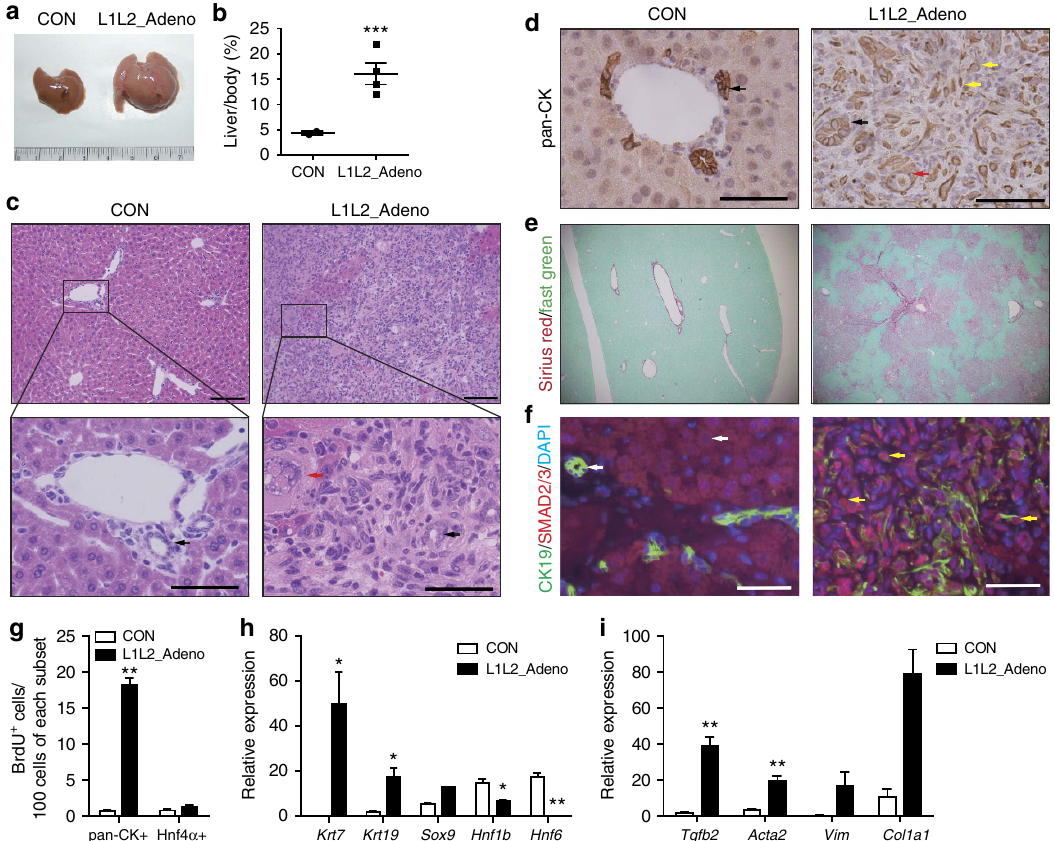
Figure 5 | Loss of Lats1/2 in adult livers causes rapid expansion of immature BECs and activation of TGF b signalling. ( a , b ) Photograph ( a ) shows livers of adeno-Cre (2X10 8 PFU)-injected control and Lats1 (cid:2) / (cid:2) ; Lats2 fl/fl mice (L1L2_Adeno) and dot graph ( b ) of liver to body weight ratio of adeno-Cre virus injected livers. ( c – f ) Representative images of haematoxylin and eosin (H&E) ( c ), anti-pan-CK ( d ), Sirius red and Fast green ( e ) and, anti-SMAD2/3 and anti-CK19 ( f ) staining of control and L1L2_Adeno livers. Black arrows indicate tubular bile ducts and yellow arrows indicate immature BECs. Red arrows indicate LCCs in hepatocytes. Scale bars in ( c ) up indicate 100 m m and scale bars in ( c ) bottom indicate 50 m m. Yellow arrows in d indicate pan-CK-positive signal. White arrows in f indicate cytoplasmic SMAD2/3 signal in CK19-positive cells; Yellow arrows in f indicate nuclear SMAD2/3 signals in CK19- positive cells. Scale bars in d and f indicate 50 m m. ( g ) Bar graph showing quantification of BrdU-positive cells out of 100 pan-CK- and HNF4 a -positive cells. ( h ) Relative mRNA expression levels of BEC-related genes in control and L1L2_Adeno livers. n ¼ 4. ( i ) Relative mRNA expression levels of Tgf b 2 and fibrotic markers in control and L1L2_Adeno livers. The data are presented as means ± s.e.m.; n ¼ 4, * P o 0.05, ** P o 0.01 and *** P o 0.005 (Student’s t